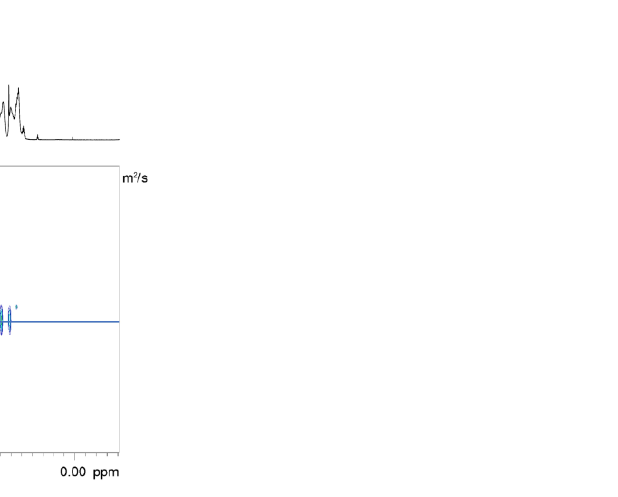
Figure 2. 2D DOSY NMR (600 MHz, CDCl 3 , 298 K) of poly (cyclohexene phthalate-block-cyclohexene carbonate) (entry 2 in Table 3).